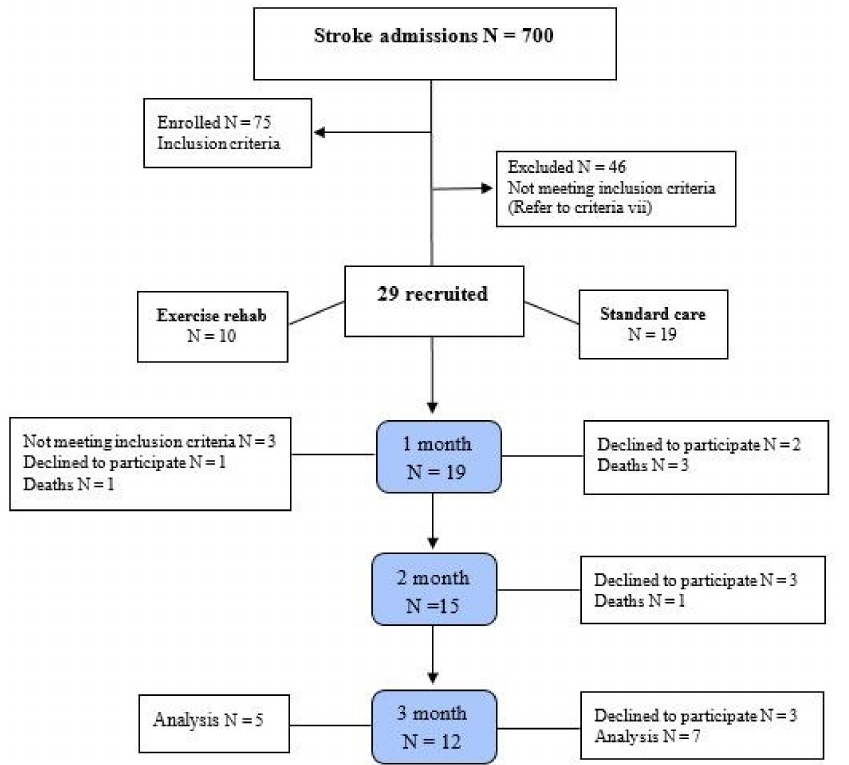
Figure 1. CONSORT flow chart of participants for recruitment, application, follow-up and